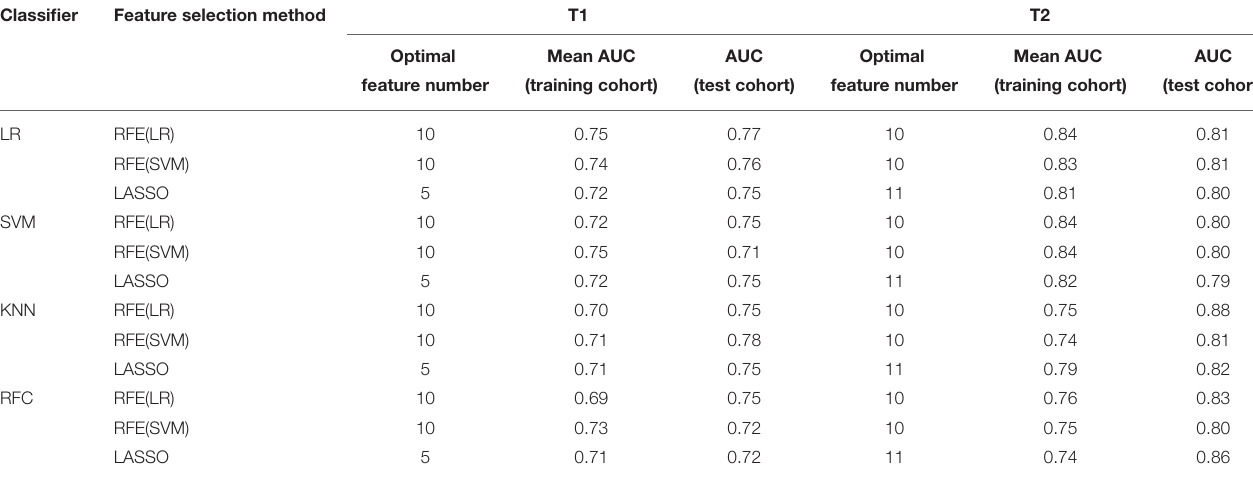
TABLE 2 | HCR model construction.